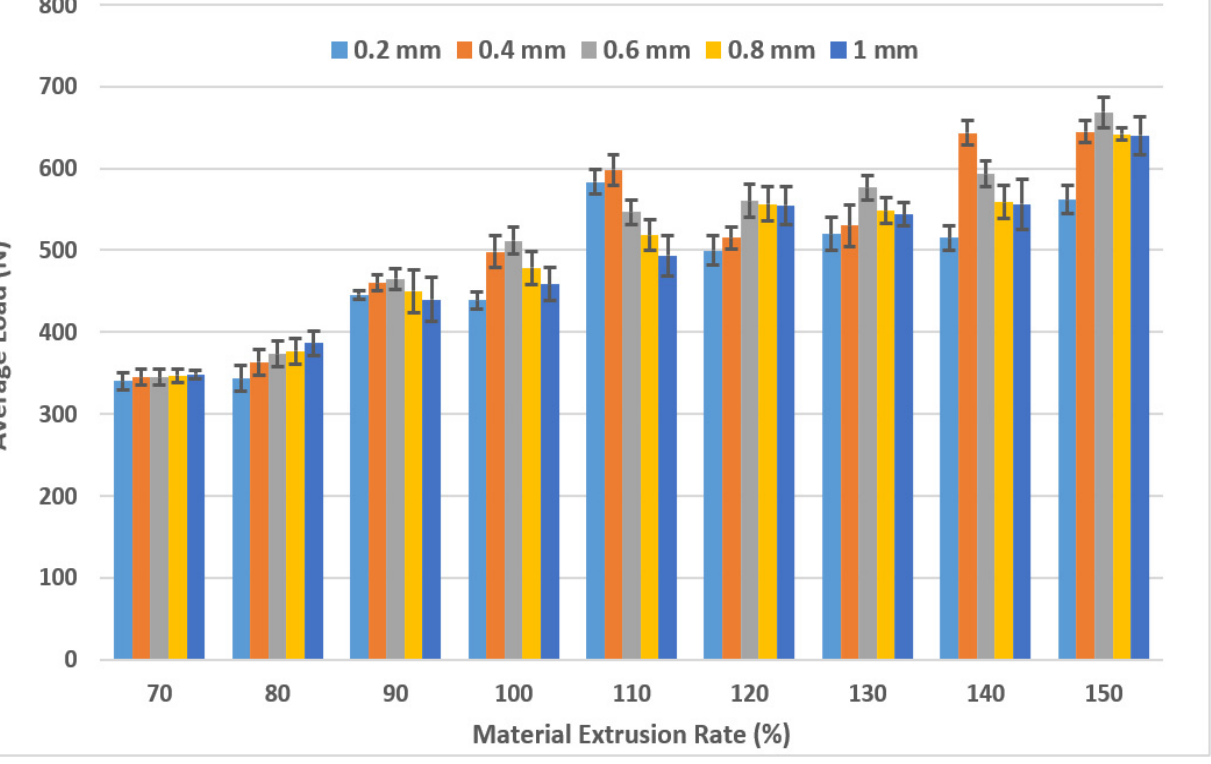
Figure 8. Results from three-point flexural testing.